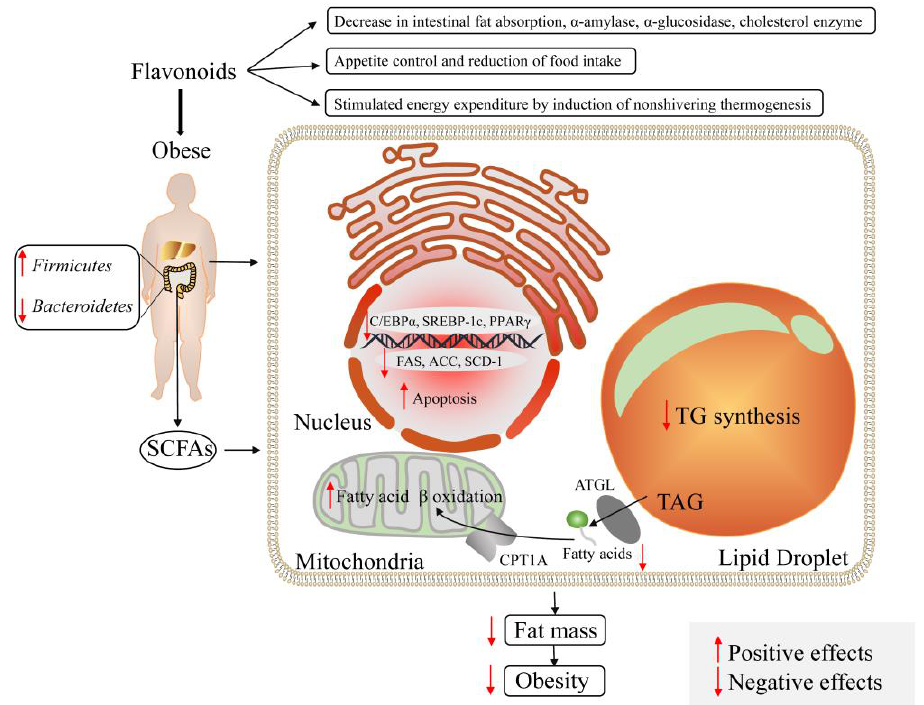
Figure 3. The main mechanisms of anti-obesity of flavonoids through modulating gut microbiota. C/EBP: CCAAT/enhancer-binding proteins, SREBP-1C: Sterol regulatory element binding protein-